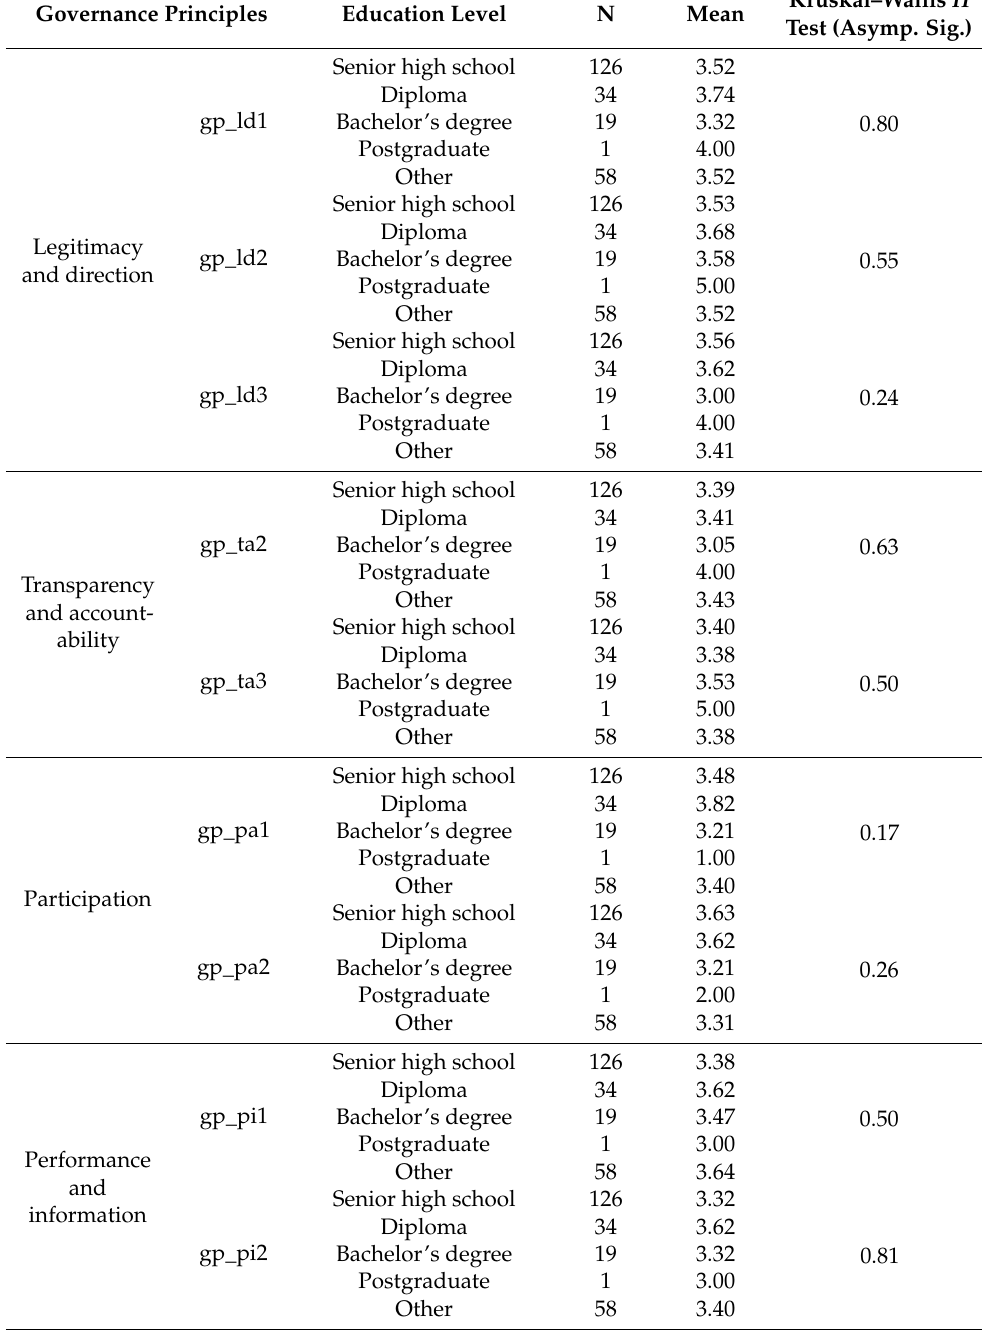
Table 11. Test of difference: education